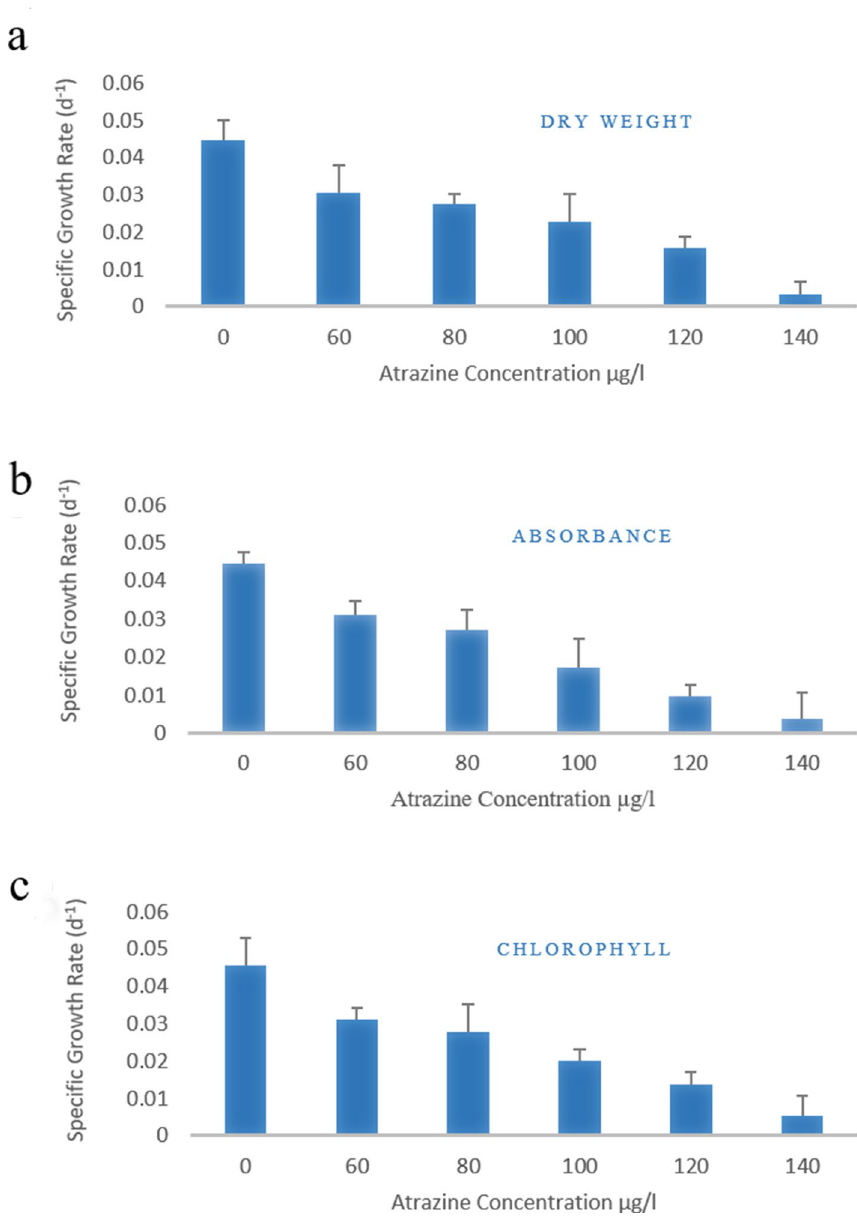
Figure 2. Effect of atrazine on the specific growth rate of C. stagnale under atrazine